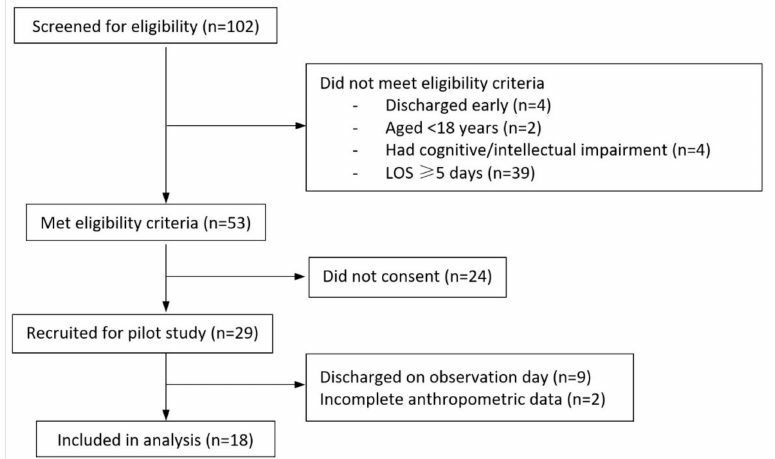
Figure 1. Participant flow during the 3-week feasibility study. LOS, length of